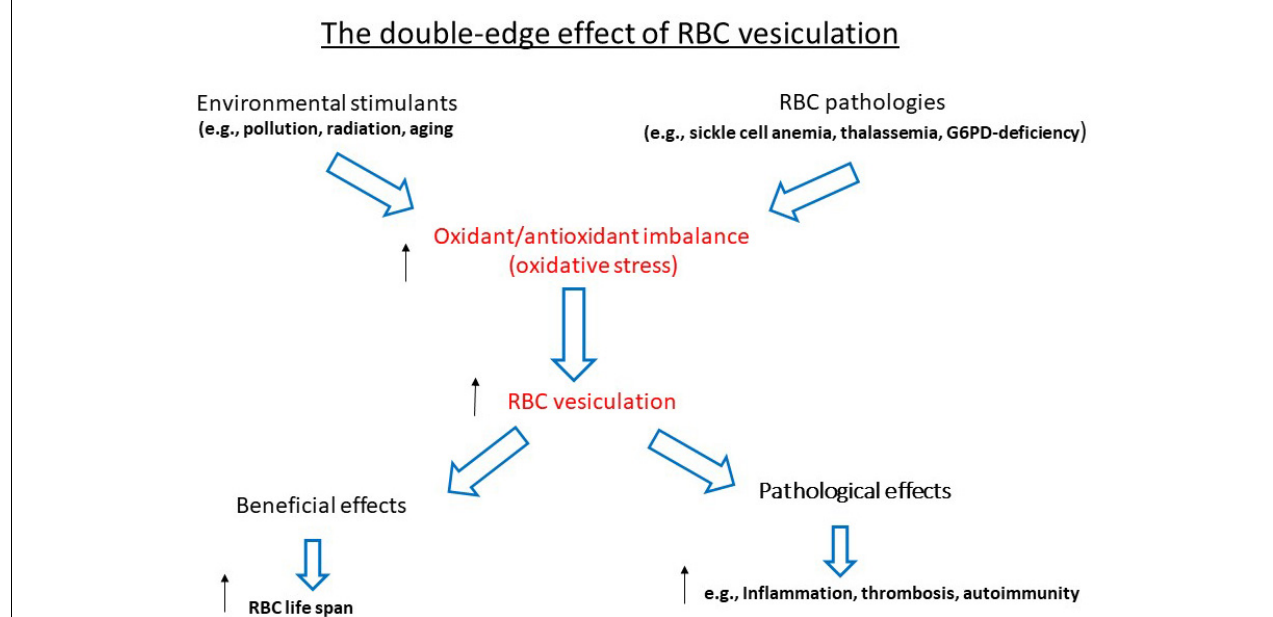
FIGURE 2 | The double-edged effect of RBC vesiculation. ↑ Upregulation; ↓ downregulation.